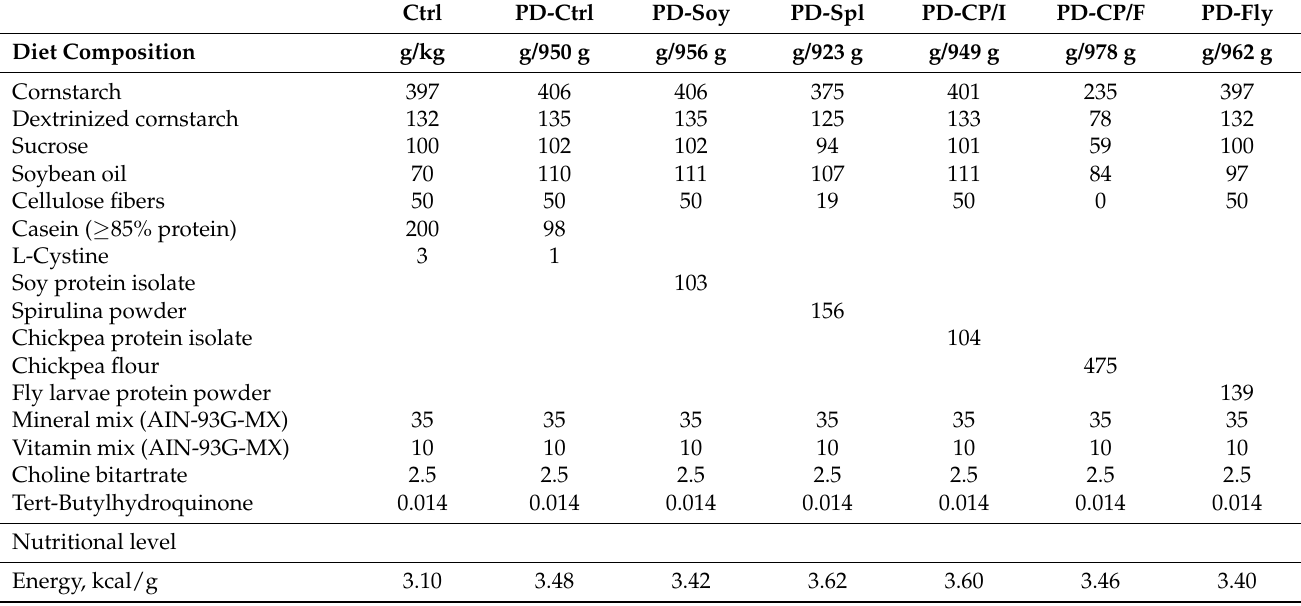
Table 1. Ingredient Composition and Nutritional Content of Diets. Values of diet composition are presented as grams per dry